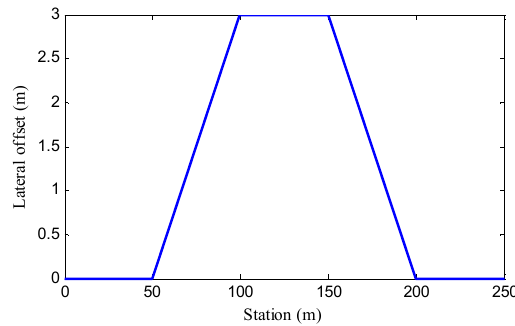
Figure 2. Double lane changes maneuver.